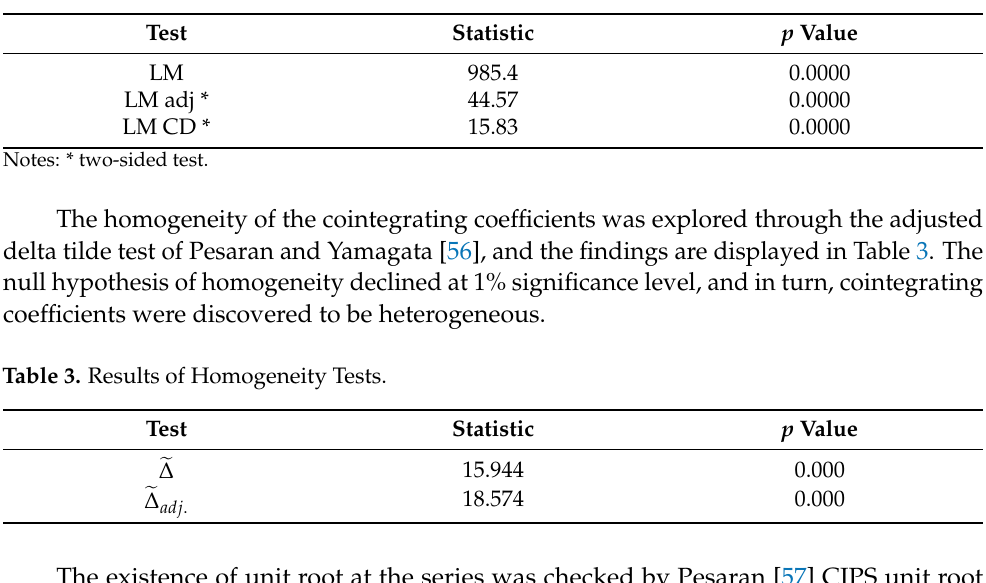
Table 2. Results of Cross-sectional dependency tests.